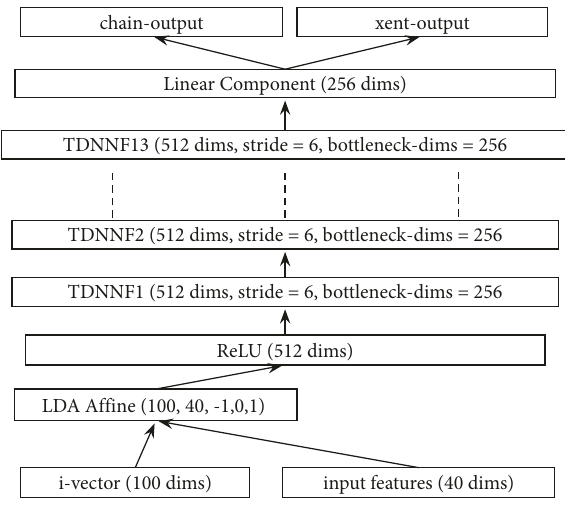
Figure 5: DNN structure for the acoustic model [39].